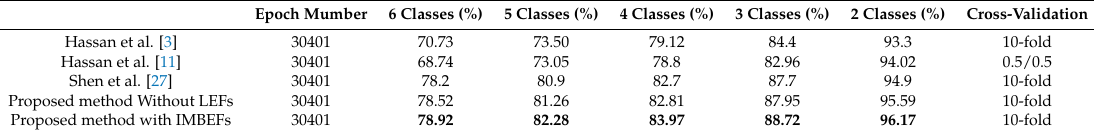
Table 30. The accuracy comparison of various published methods on DRMS database under the R&K standard. Highest accuracy in each case is highlighted in bold.